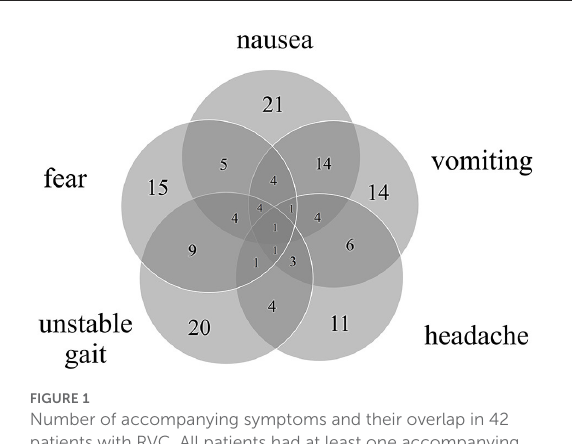
FIGURE1 Number of accompanying symptoms and their overlap in 42 patients with RVC. All patients had at least one accompanying symptom, most commonly nausea, unstable gait, and expression of